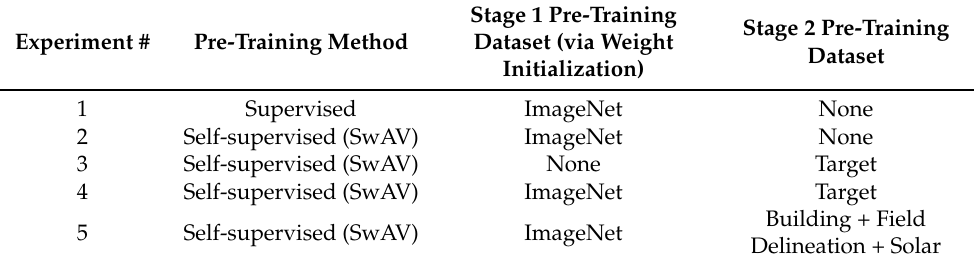
Table 1. The first experiment used an encoder pre-trained using supervision on the ImageNet classification challenge. The second encoder was pre-trained using SwAV on ImageNet, and the third was pre-trained using SwAV on just the target data. For experiment four, we applied SwAV to the target data using the weights initialized from being pre-trained on ImageNet. Lastly, for experiment five, we took the initialized encoder using SwAV on ImageNet and then further applied SwAV using all three datasets to determine whether the model benefited from seeing a larger quantity of remote sensing